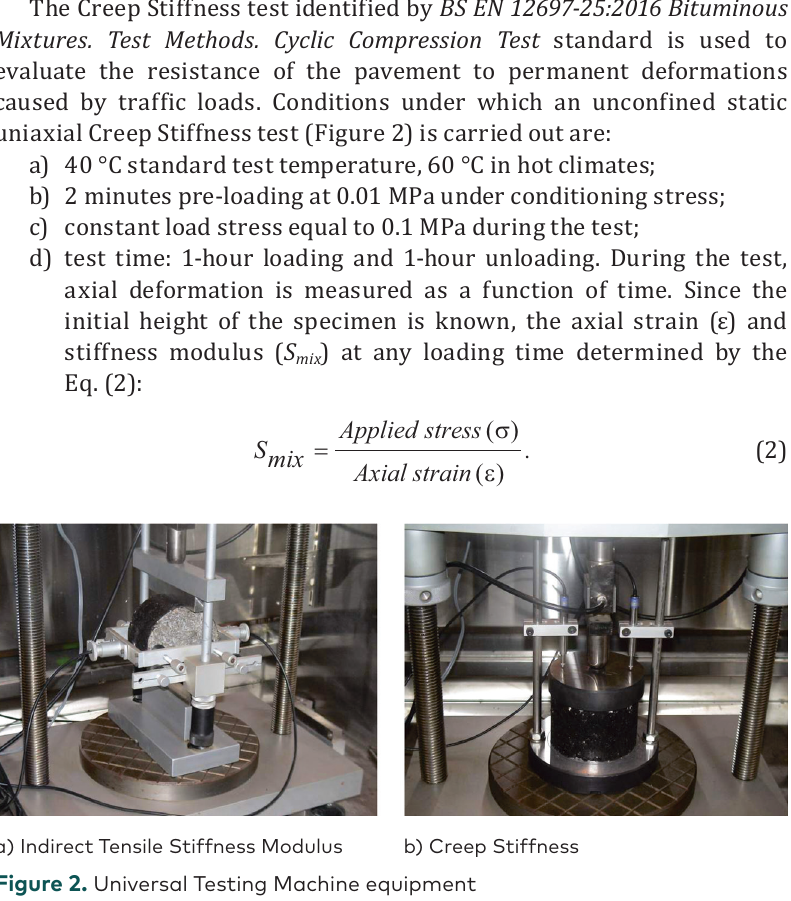
Figure 2. Universal Testing Machine